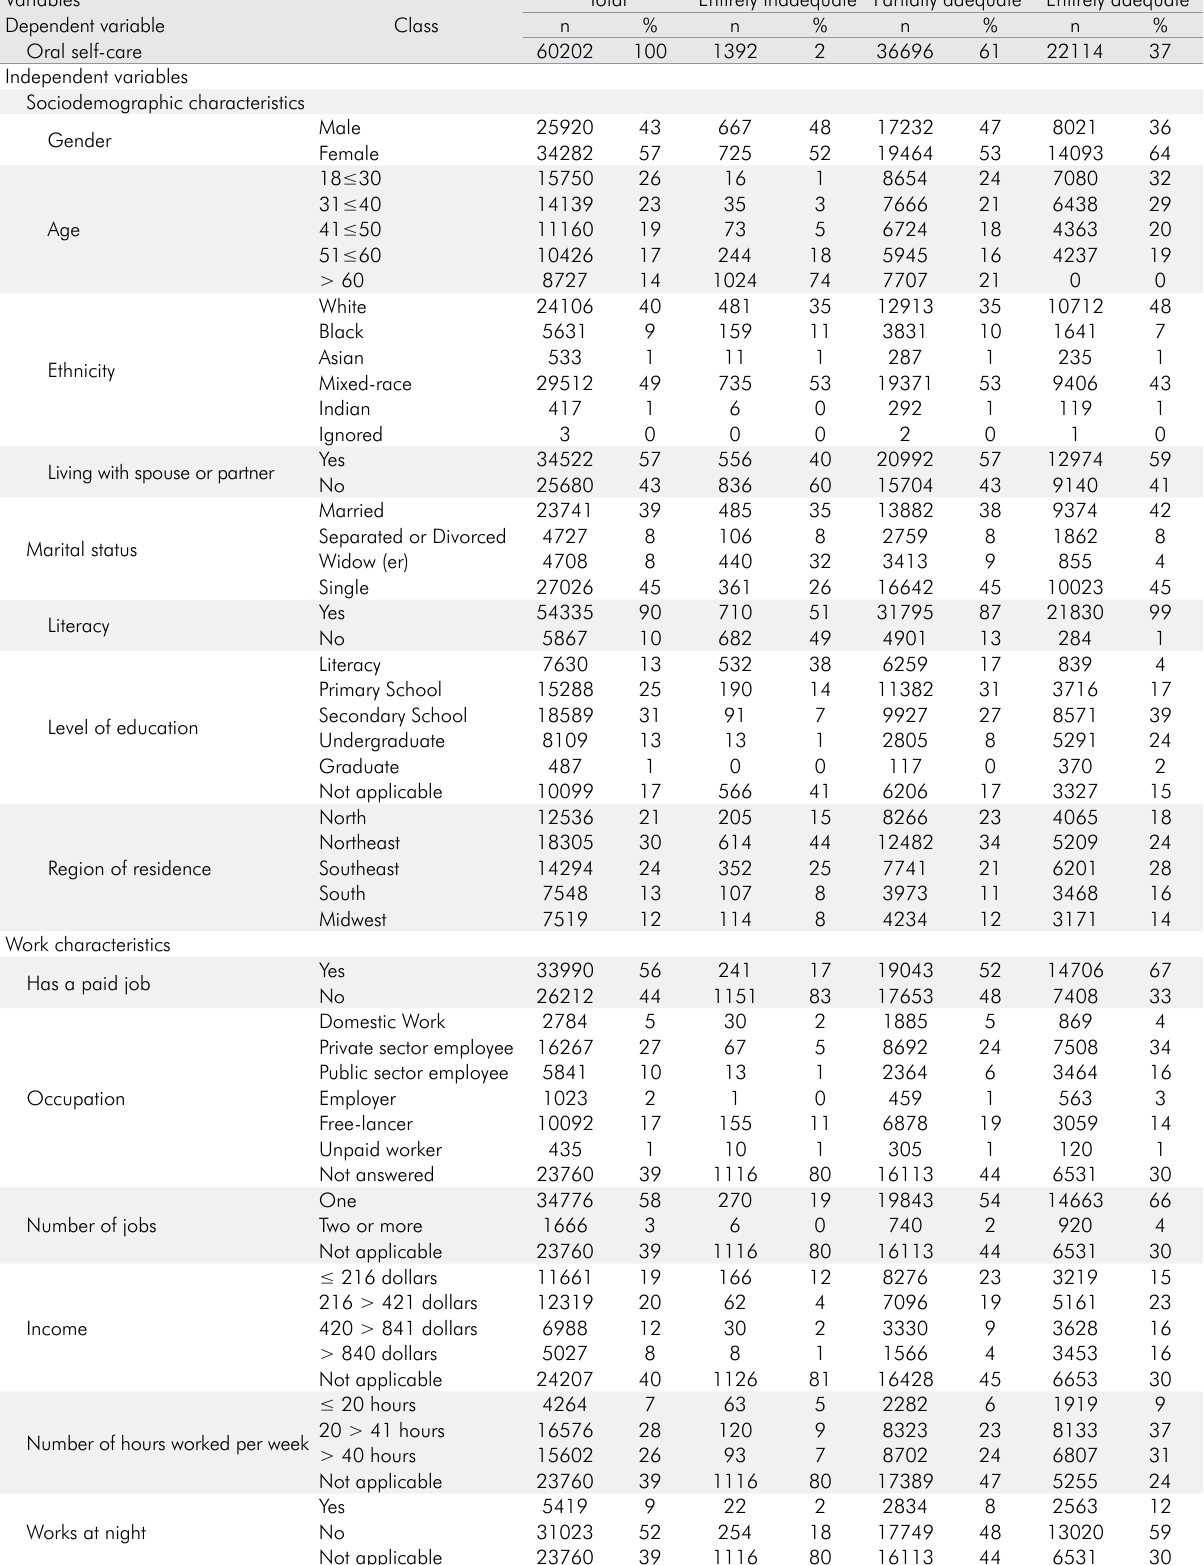
Table 1. Description of the sample, according to sociodemographic and work characteristics. Brazil. 2013. (n = 60202).